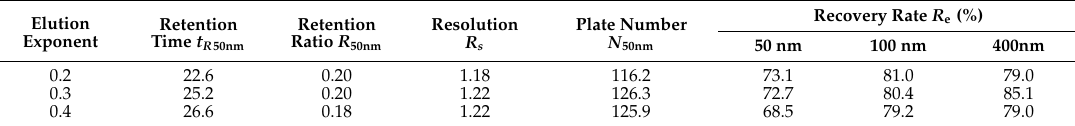
Table 3. Chromatographic parameters for the separation of a polystyrene nanoparticle mixture